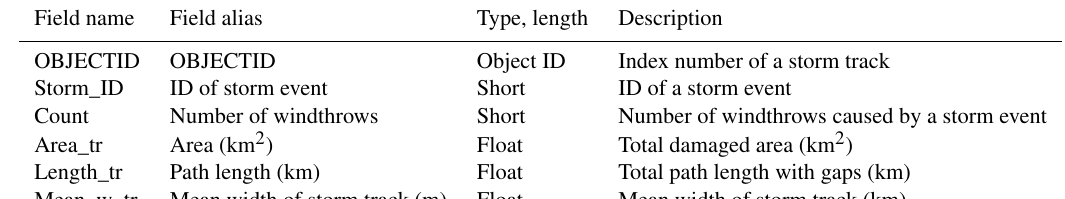
Table 3. Attribute table of the GIS layer of storm events tracks.